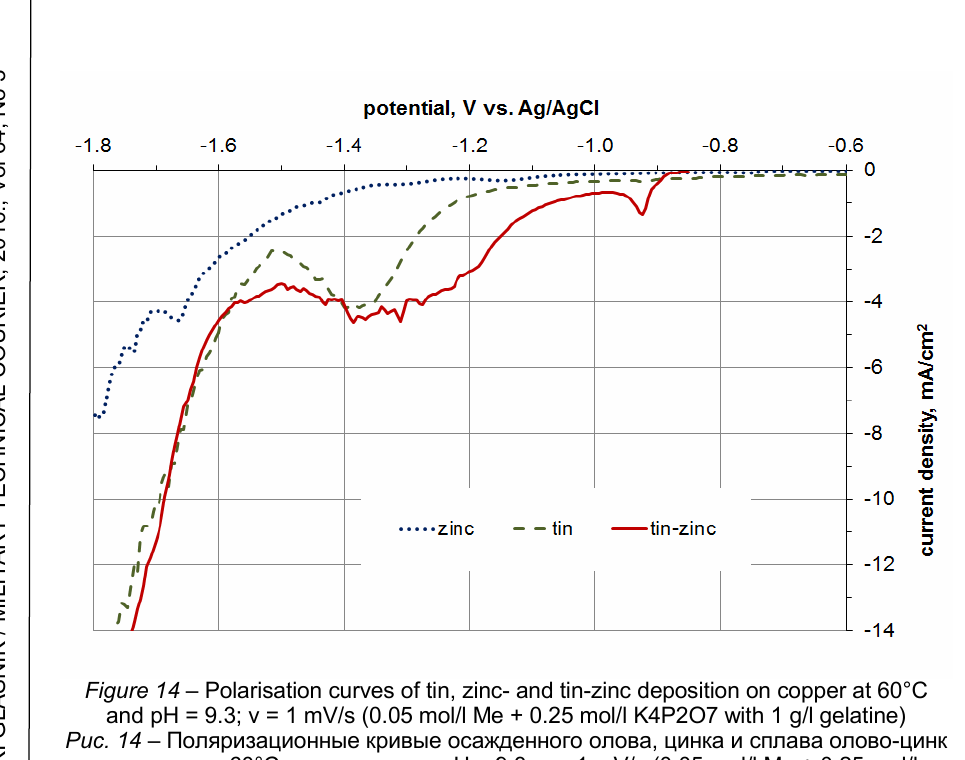
Figure 14 – Polarisation curves of tin, zinc- and tin-zinc deposition on copper at 60°C and pH = 9.3; v = 1 mV/s (0.05 mol/l Me + 0.25 mol/l K4P2O7 with 1 g/l gelatine) Рис . 14 – Поляризационные кривые осажденного олова , цинка и сплава олово - цинк на меди при 60°C, со значением pH = 9.3; v = 1 mV/s (0.05 mol/l Me + 0.25